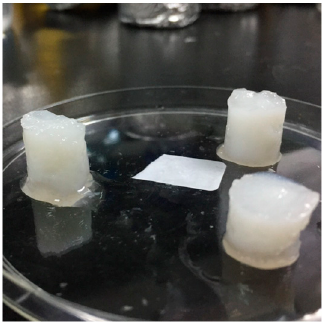
Figure 8. The physical appearance of construct F8 [4% CNC: 4% Alg: 40% PEGDA].